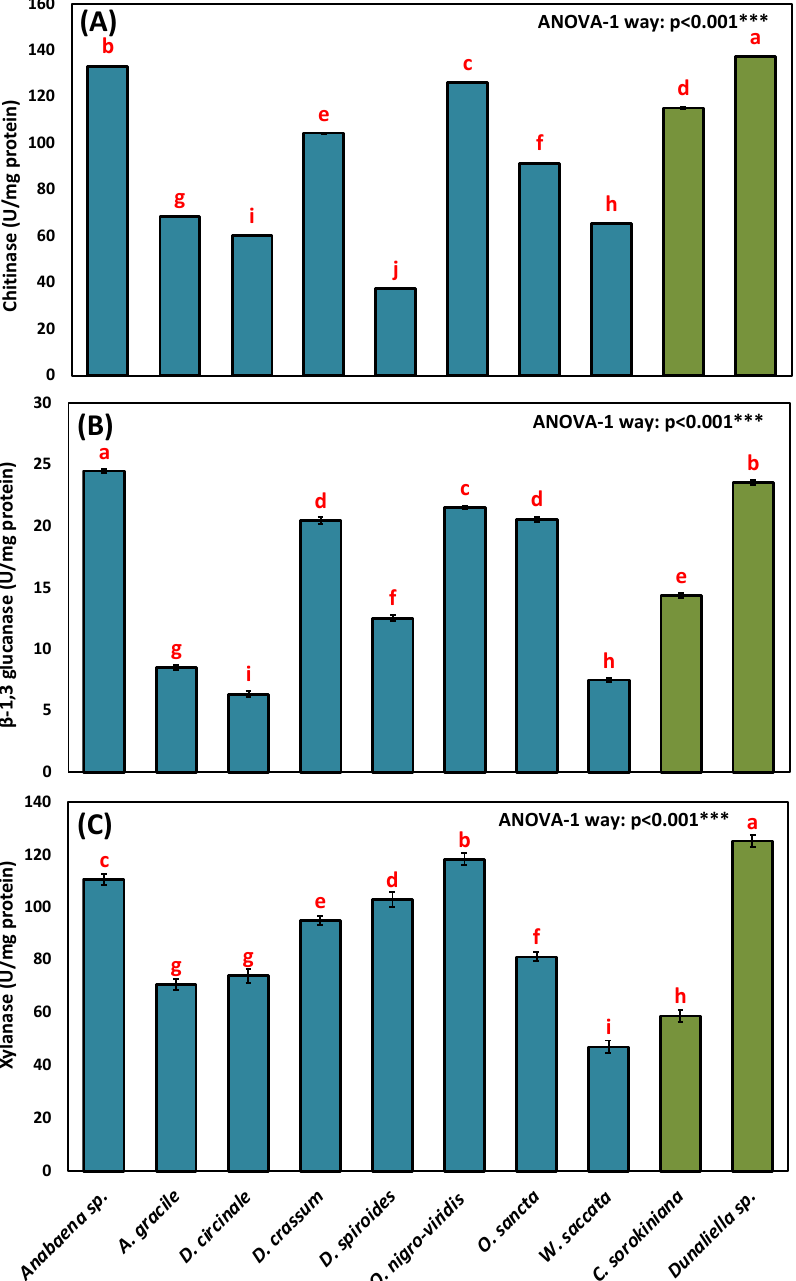
Figure 2. Enzyme activities of the different investigated cyanobacterial and algal strains: ( A ) chitinase, ( B ) β -1,3-glucanase, ( C ) xylanase. Bars with different superscript letters were significantly different according to DMRT at p < 0.05. *** significant at p < 0.001.